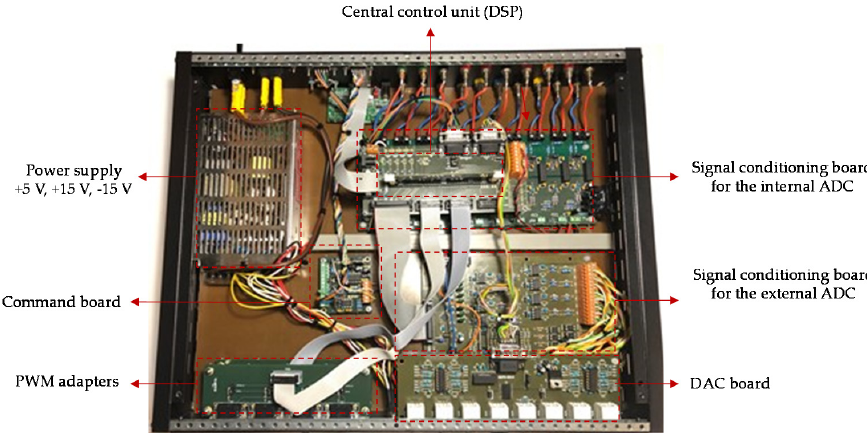
Figure 14. Control system hardware fitted in a metallic box. Figure 14